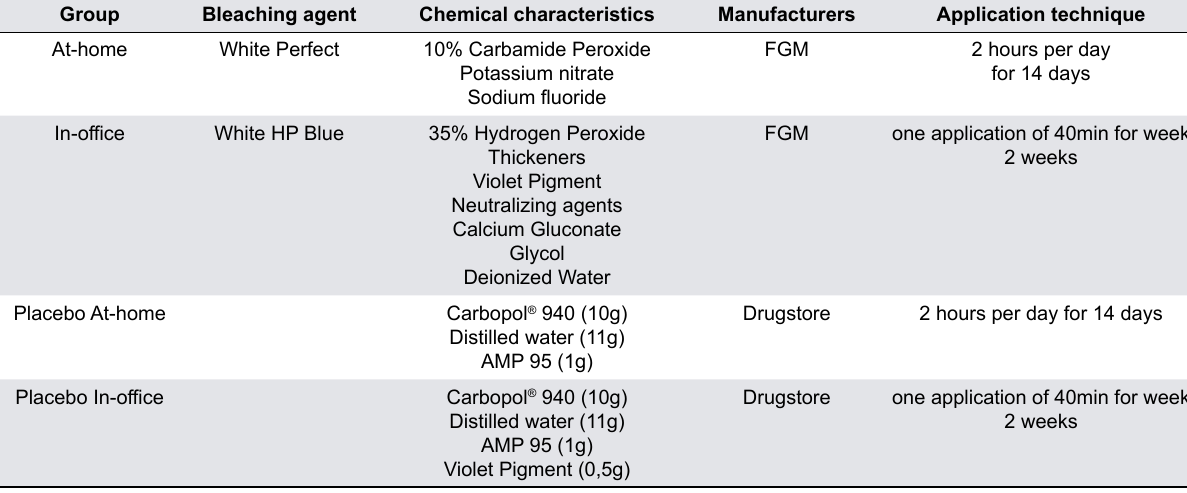
Table 1- Bleaching agents tested, their chemical characteristics and manufacturers